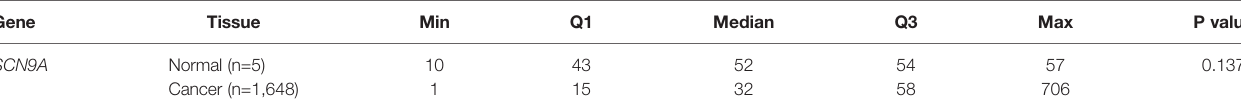
TABLE 4 | mRNA expression of SCN9A in normal versus ovarian cancer tissue.